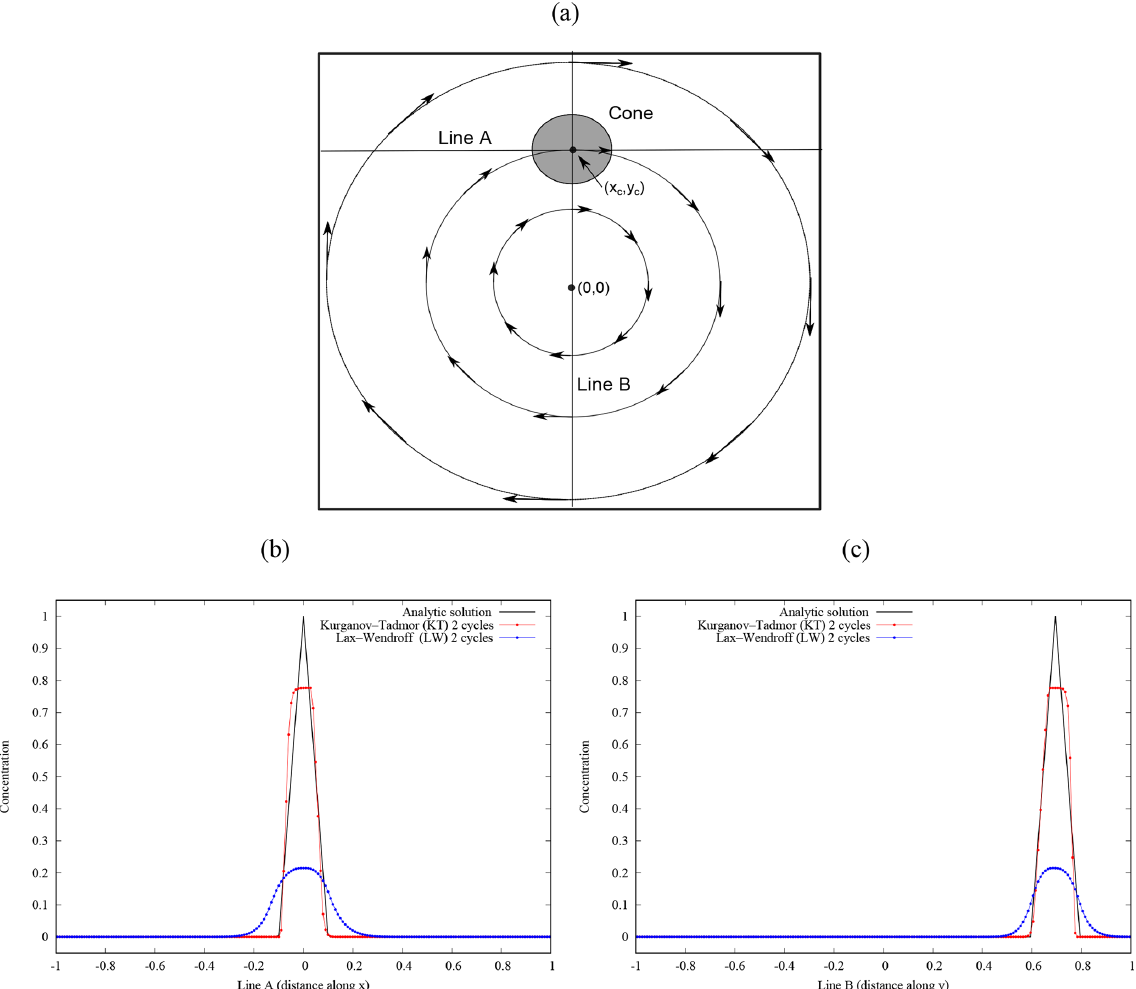
Figure 5. Benchmark 3 results. (a) A cone centred at (x c ,y c ) = ( 0 , 0 . 695 ) with radius r = 0 . 1 (shaded circle) is advected by a rotating velocity field with angular velocity (cid:127) = π in a computational domain (x,y) ∈ [− 1 , 1 ]×[− 1 , 1 ] . Plots in panels (b) and (c) show concentration profiles after two cycles along lines A ( y = y c ) and B ( x = 0). The solid black line shows the analytic solution after each cycle. Red and blue dots show the KT + RK4 and LW + EU1 numerical solutions, respectively. Results use 200 equally spaced cells along each direction.